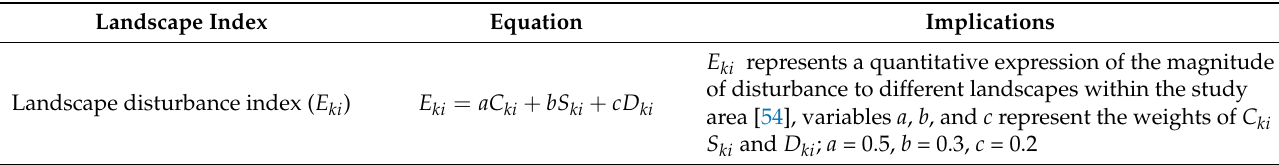
Table 2. Landscape indexes and their